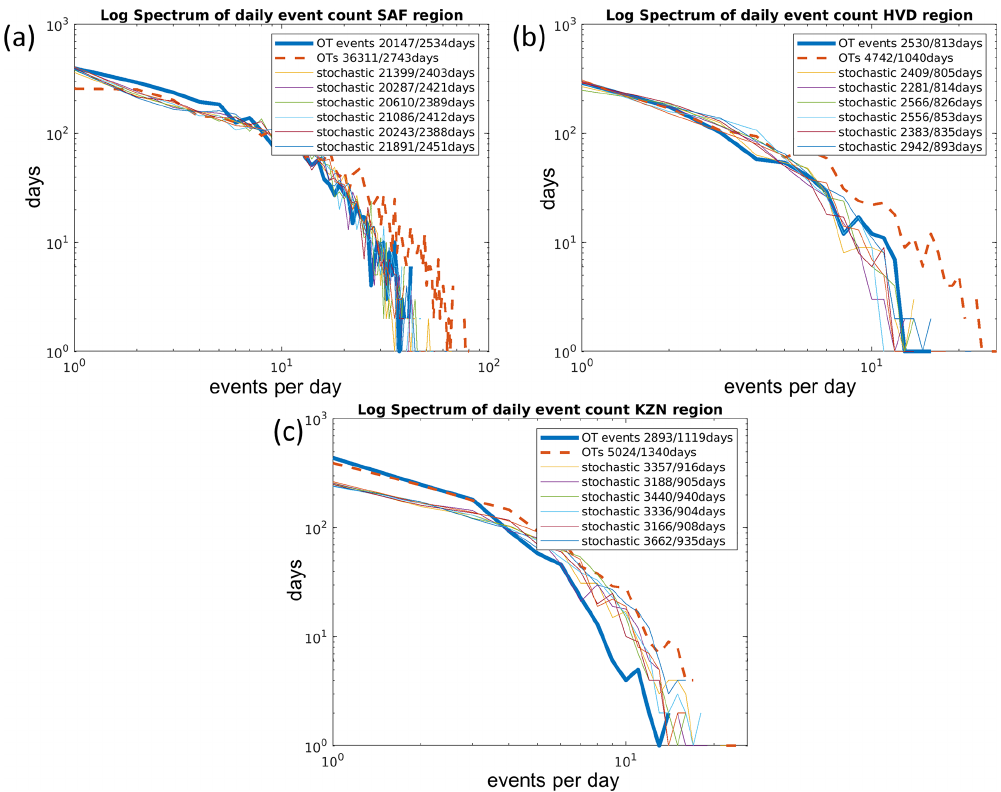
Figure 16. As Fig. 15, but comparing subsets of the stochastic event set to the historic OT event set (as well as the set containing events lasting only 1 time step) for each region. (a) South Africa, (b) the Highveld, and (c) KwaZulu-Natal. Numbers indicate the total count and total number of days on which these occurred for each